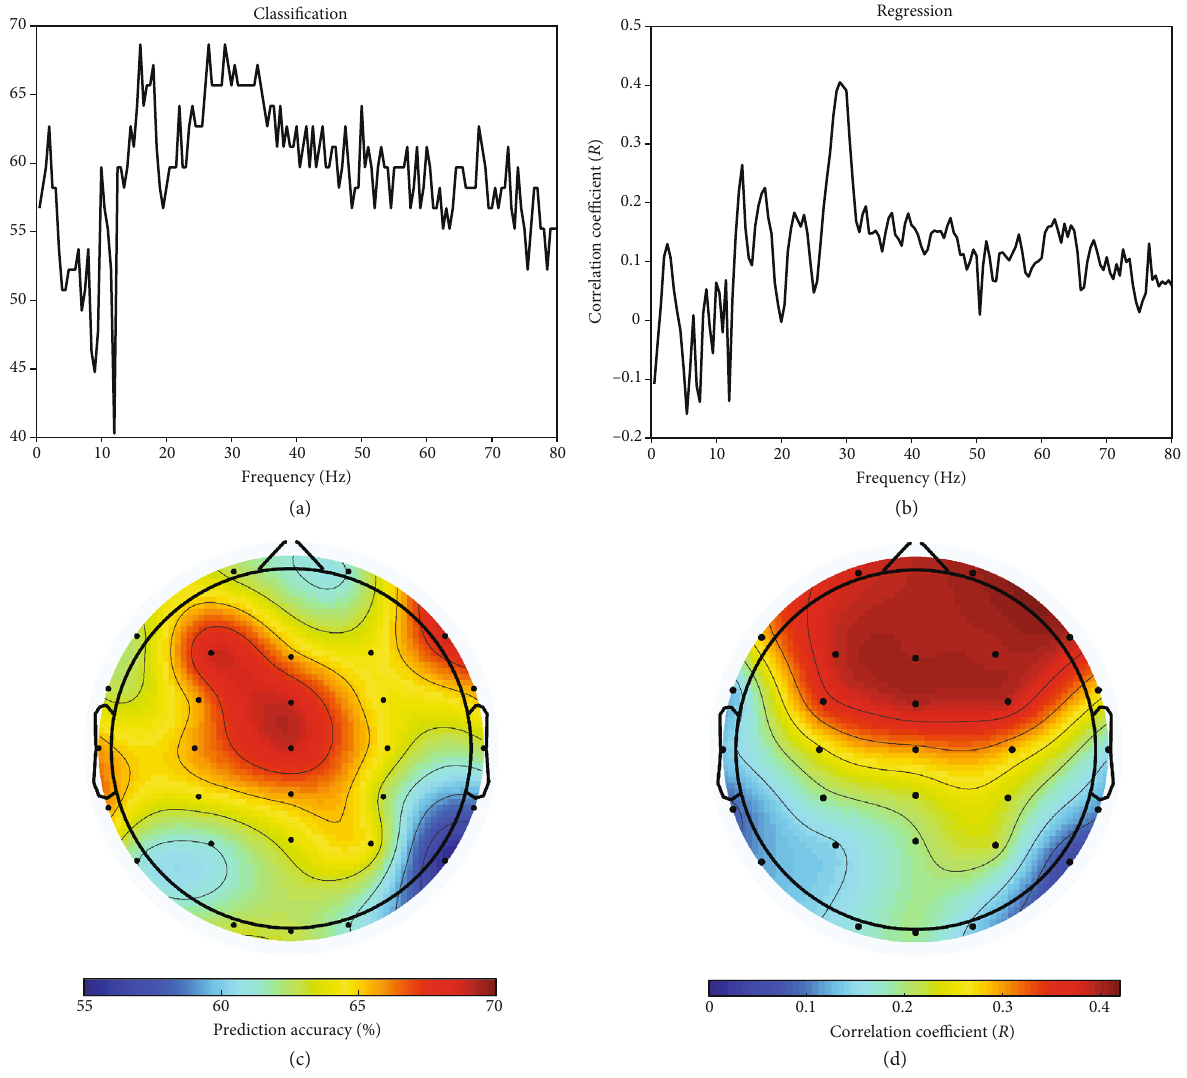
Figure 4: The contribution of presurgery EEG features on the performance of classi fi cation and regression to predict the intensity of postoperative pain ((a, b) in the frequency domain; (c, d) in the spatial